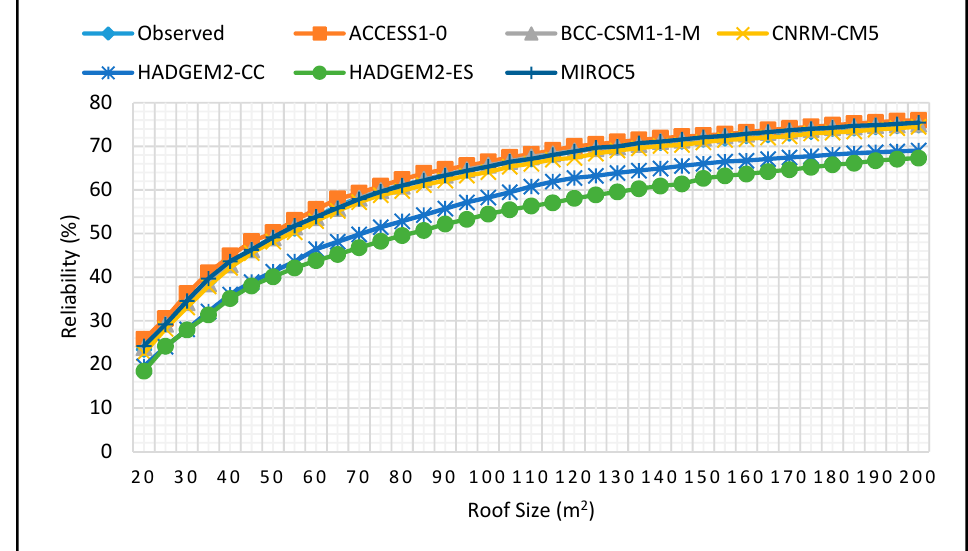
Figure 10. Reliability projections for DJF season for 0.5 m 3 tank size for 2025–2055.